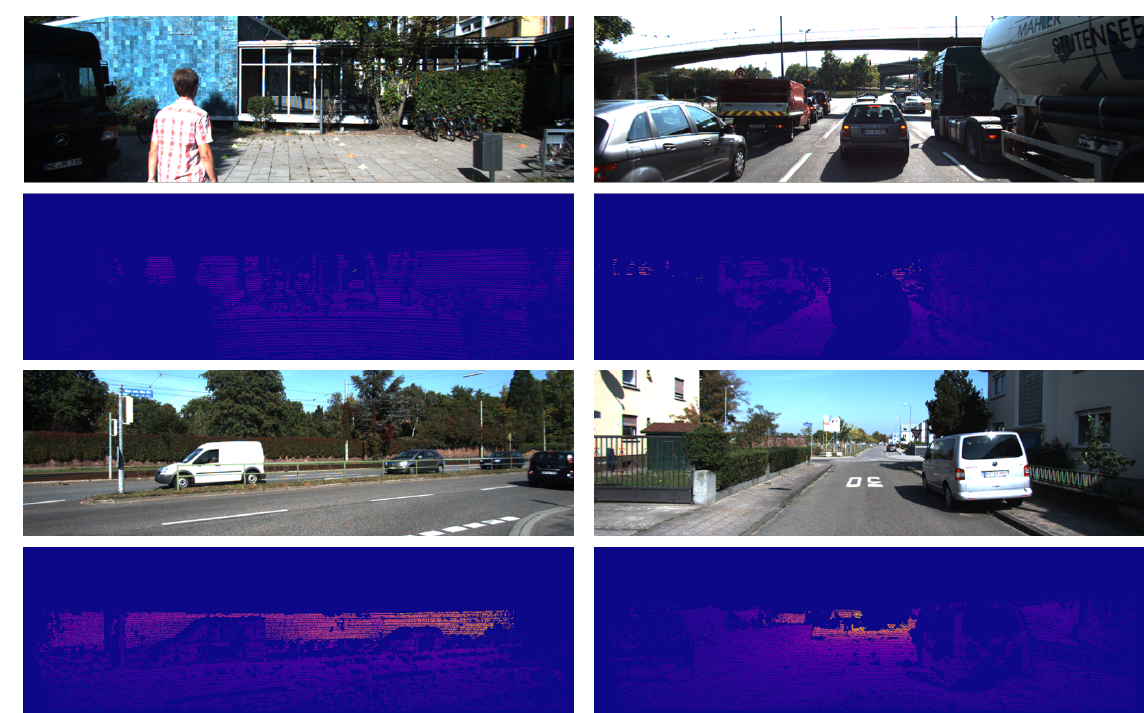
Figure 6. Original image ( 1st row , 3rd row ); generated Ground Truth (2nd row , 4th row ).